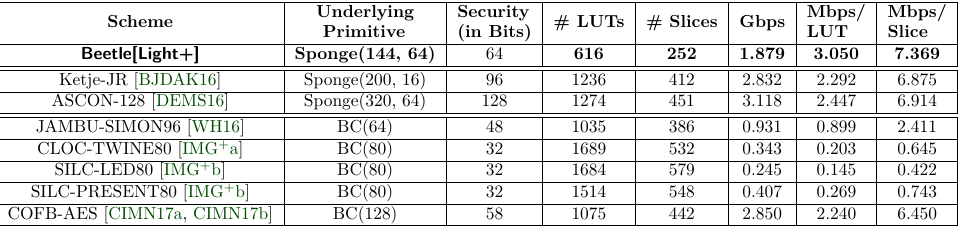
Table 5: Benchmarking Beetle[Light+] on Virtex 6. Sponge( b , r ) denotes the scheme follows sponge mode with rate r and uses a b -bit permutation. BC( n ) denotes the scheme follows a blockcipher based mode with an n -bit